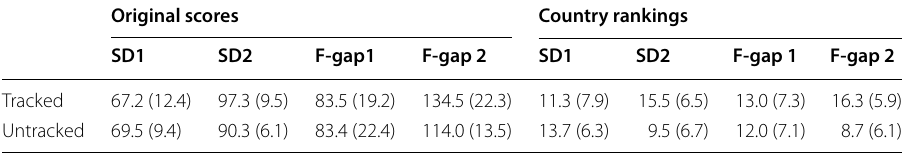
Standard deviations in parenthesis. Rank: 1 smallest, N largest = = Under the heading F‑gap1 and F‑gap2 we report results relative to the effect of tracking on the difference between tertiary educated parents with the largest number of books and no tertiary educated parents with the lowest number of books: